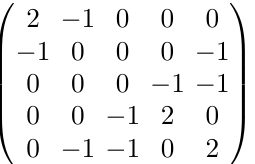
Figure 4 . Distinguished Dynkin diagram of the (cid:12)nite-dimensional contragredient Lie superalgebra A (3 ; N (cid:0) 1), which has the superconformal algebra su (2 ; 2 jN ) in D = 4 as a real